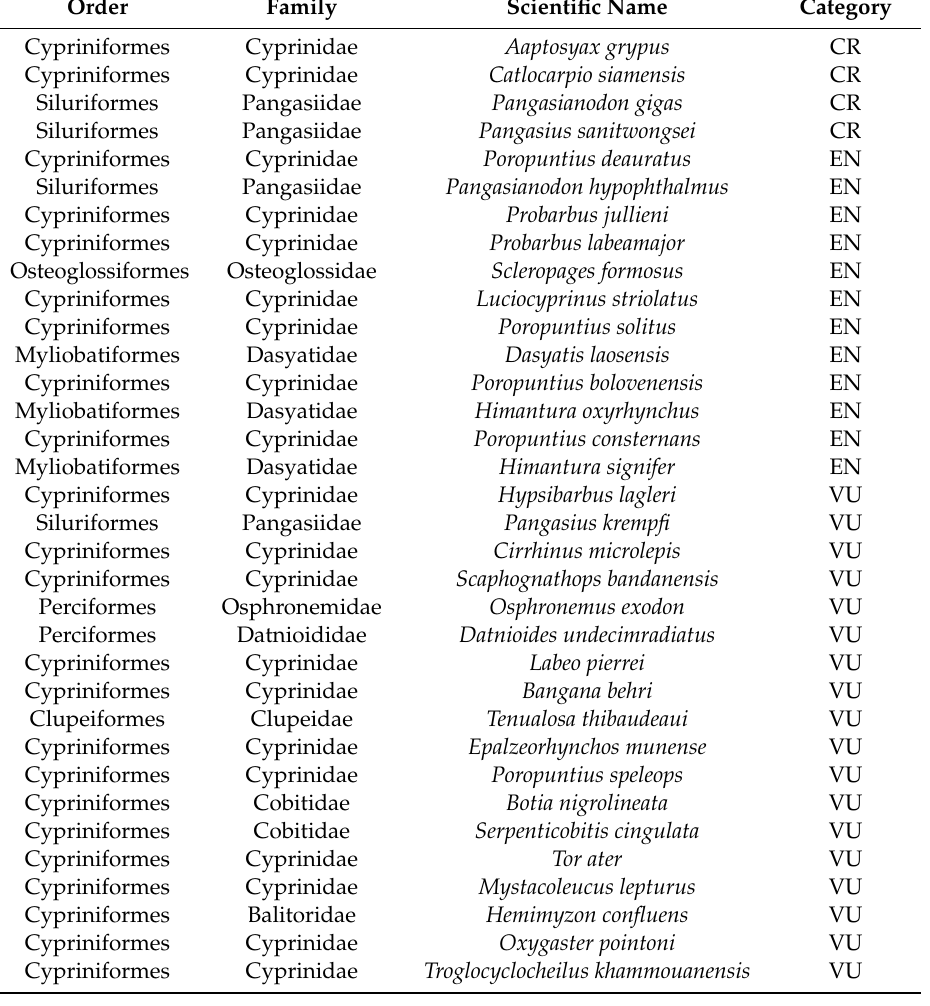
Table 1. Threatened species categorized by IUNC Red List: CR = critically endangered; EN = endangered; VU =